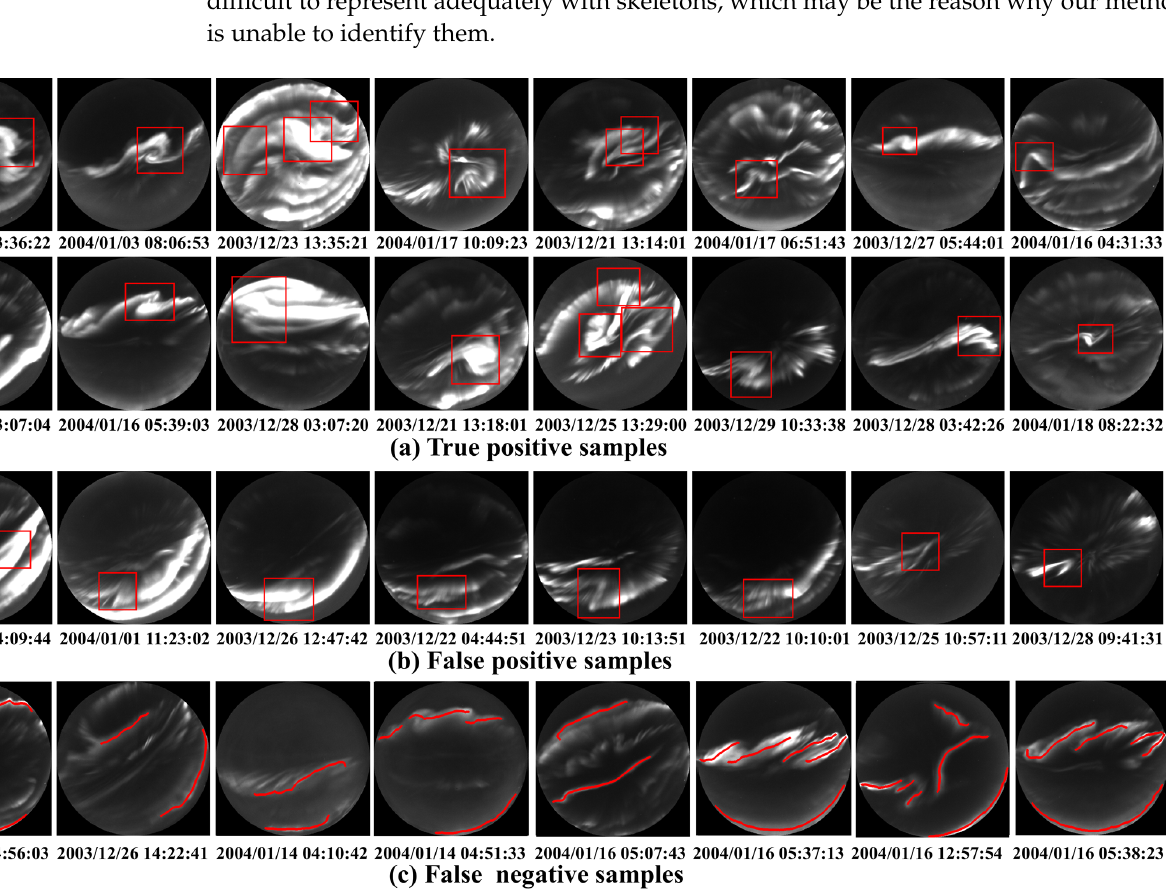
Figure 8. The retrieval results of the fold structure in the large-scale dataset. ( a ) True positive sam- ples, ( b ) false positive samples and ( c ) false positive samples. ( b ) false positive samples and ( c ) false positive